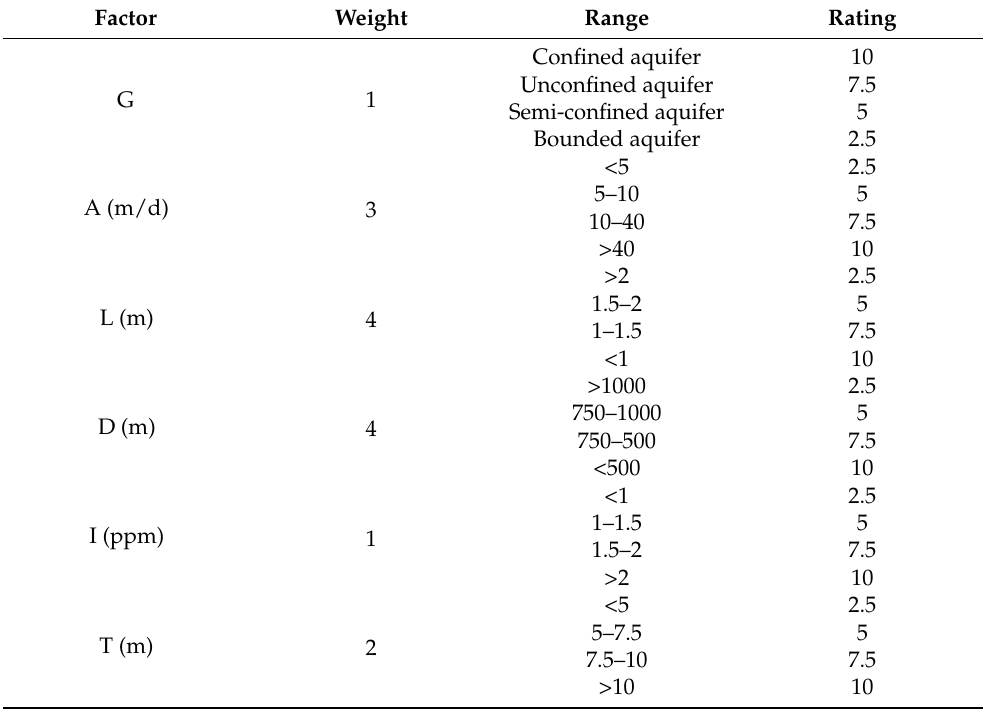
Table 2. Weights, ranges and rating of six factors for the original GALDIT method. Factor